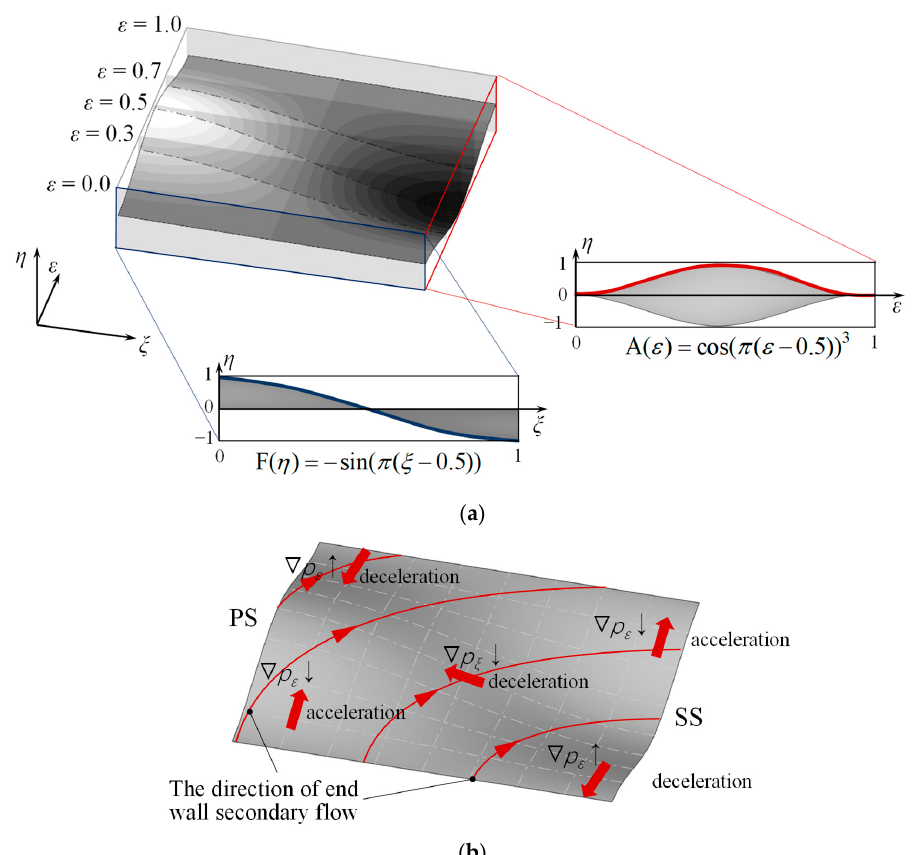
Figure 2. The full-area unit. ( a ) Definition of the full-area unit; ( b ) The effect on the pressure field and the end wall secondary flow.